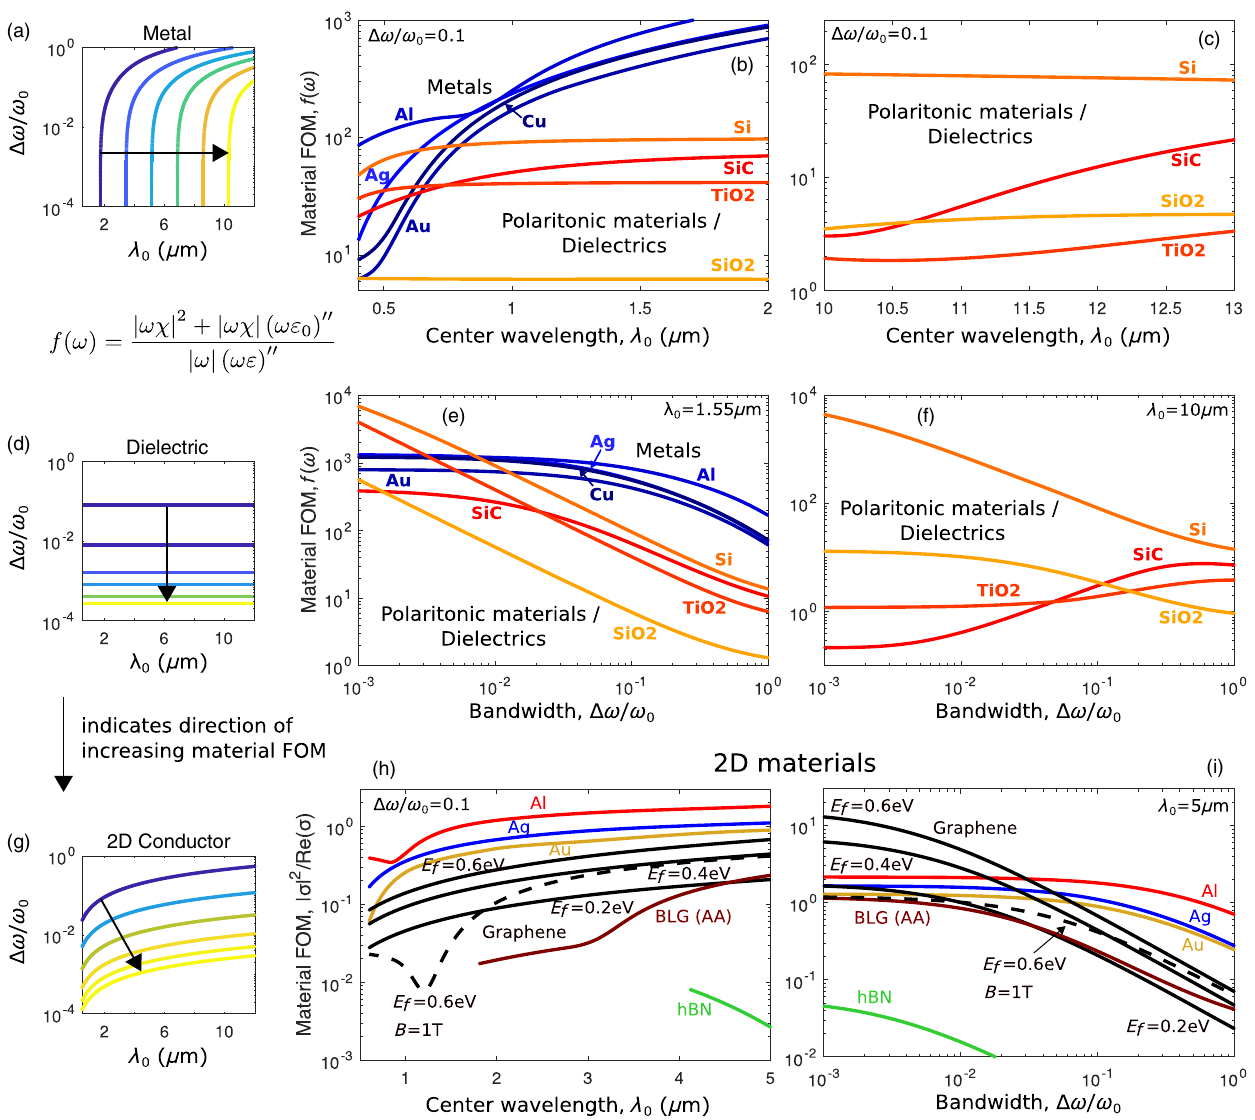
FIG. 5. (a,d,g) Isocurves of material FOM for a Drude metal (with material loss rate γ ¼ 0 . 1 ω p ), a lossless dielectric (of susceptibility χ ¼ 9 ), and a Drude 2D material (with γ ¼ 0 . 01 ω p ). The arrows indicate increasing material FOM in each case. (b) Comparison of material FOM for various bulk metals and polaritonic materials or dielectrics, keeping the bandwidth-to-center-frequency ratio Δ ω = ω 0 fixed to 0.1. For the modestly large 10% relative bandwidth, the large susceptibilities of metals compensates for their material loss, generally resulting in greater maximum response. Part (c) compares surface-phonon-polariton-supporting materials at mid-IR wavelengths. (e,f) Comparison of material FOM for varying bandwidths relative to the center wavelengths of 1.55 and 10 μ m. At very narrow bandwidths, dielectrics offer a greater possible response than metals. (h,i) Comparison of material FOM for 2D materials for different choices of center wavelength and Δ ω = ω 0 (2D Al, Ag, and Au properties derived from their bulk